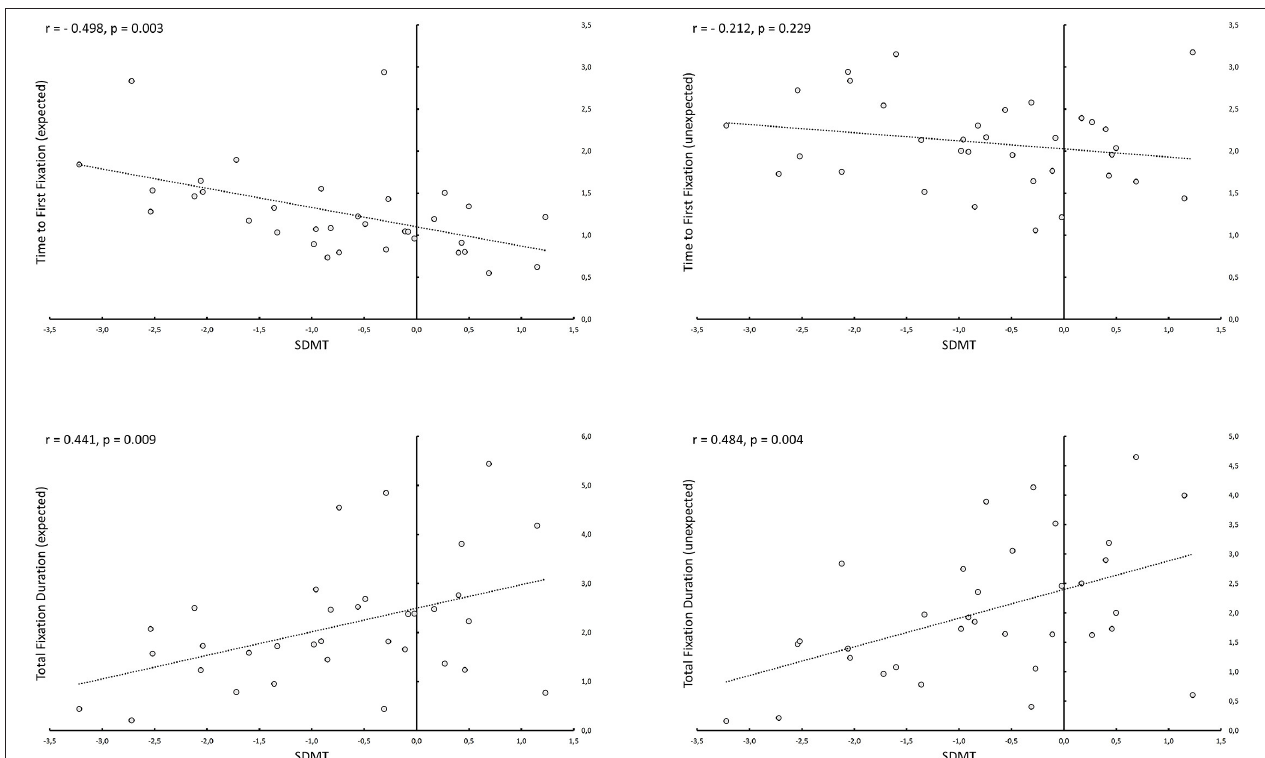
FIGURE 3 | Correlations between SDMT and eye tracking parameters depending on the expectedness of the location of the target. Cognitive performance as measured by SDMT correlated inversely with the time to first fixation for conditions, in which previously announced targets were located in their expected positions (e.g., milk carton in the fridge). However, there was no significant correlation for the conditions, in which the previously announced targets were located in unexpected positions (e.g., milk carton on the floor). For total fixation duration SDMT correlated significantly with eye tracking parameters in both expected and unexpected